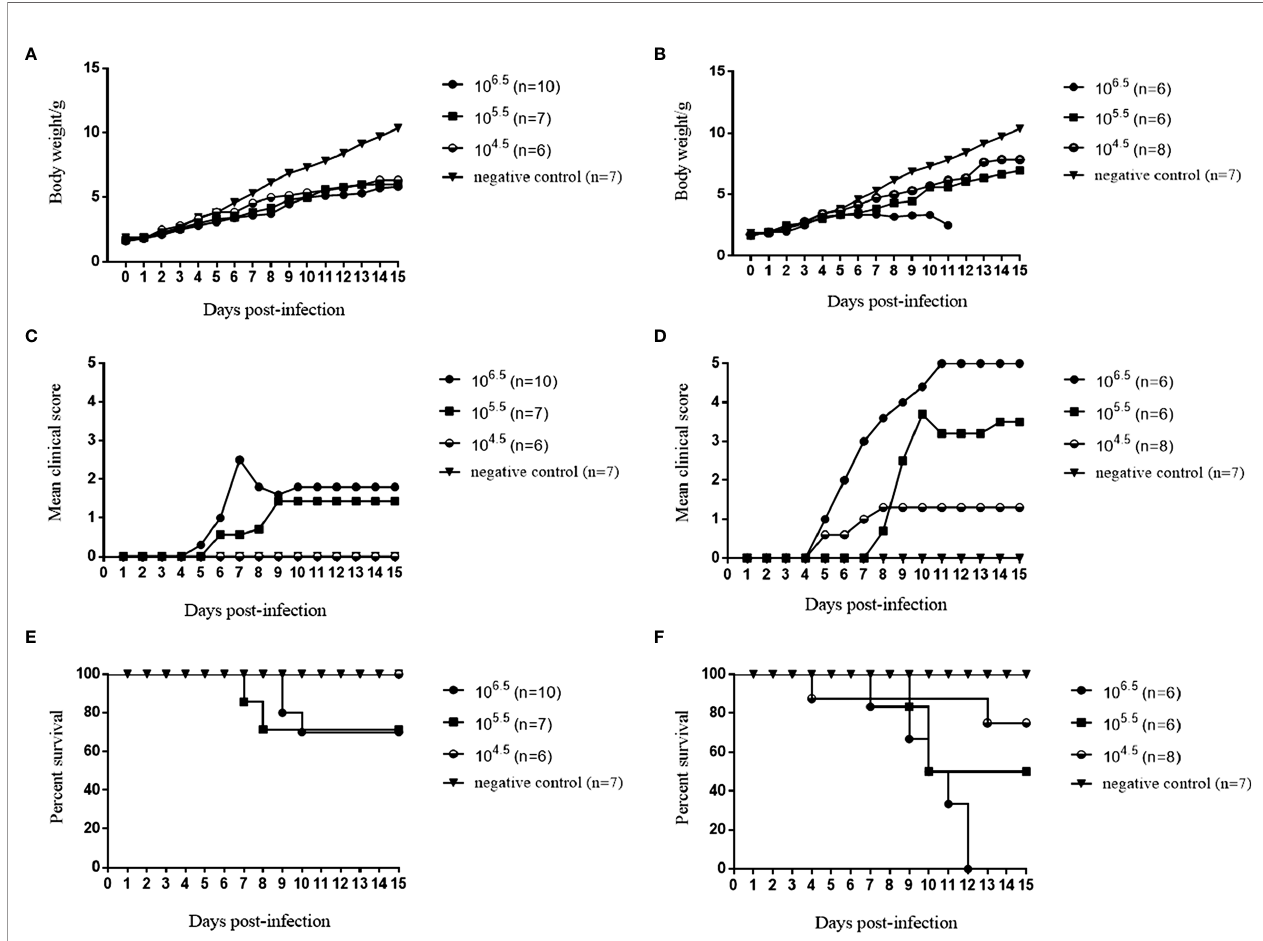
FIGURE 4 | Comparison of virulence of the RYN-A1205 and KYN-A1205 strains. The body weight, mean clinical score and percent survival of neonatal mice injected with the RYN-A1205 strain (A, C, E) . The mean clinical score and percent survival of neonatal mice injected with the KYN-A1205 strain (B, D, F) . Negative control mice were administered an equal volume of an uninfected cell supernatant instead of the